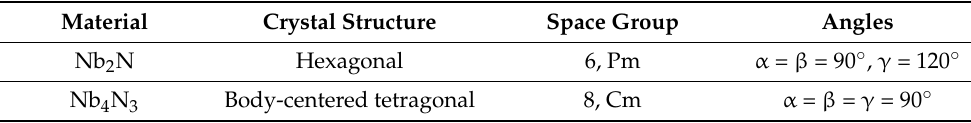
Figure 1. Chemical structures of pristine niobium nitride: ( a ) Nb 2 N; ( b ) Nb 4 N 3 . Table 1. Crystal parameters used for calculations. Material Crystal